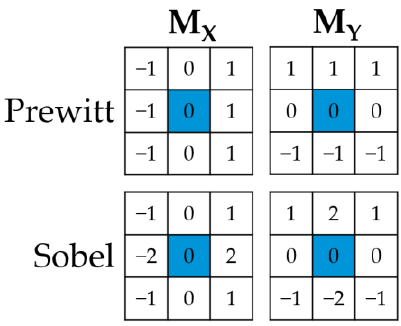
Figure 4. Two examples of a pair of masks used to approximate the Cartesian components of an image’s intensity gradient.